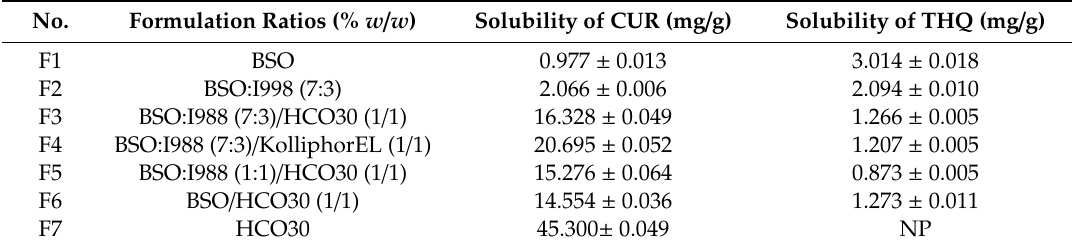
Table 2. Equilibrium solubility of curcumin (CUR) and thymoquinone (THQ estimated from BSO) in various SNEDDS / Bio-SNEDDS formulations ( n = 3, mean ±